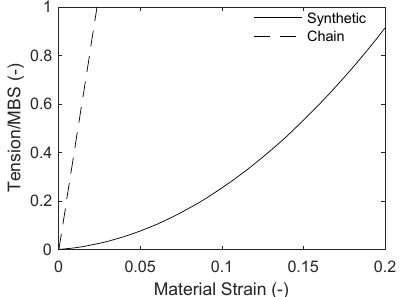
Figure 5. Material Tension-Strain Relationships.